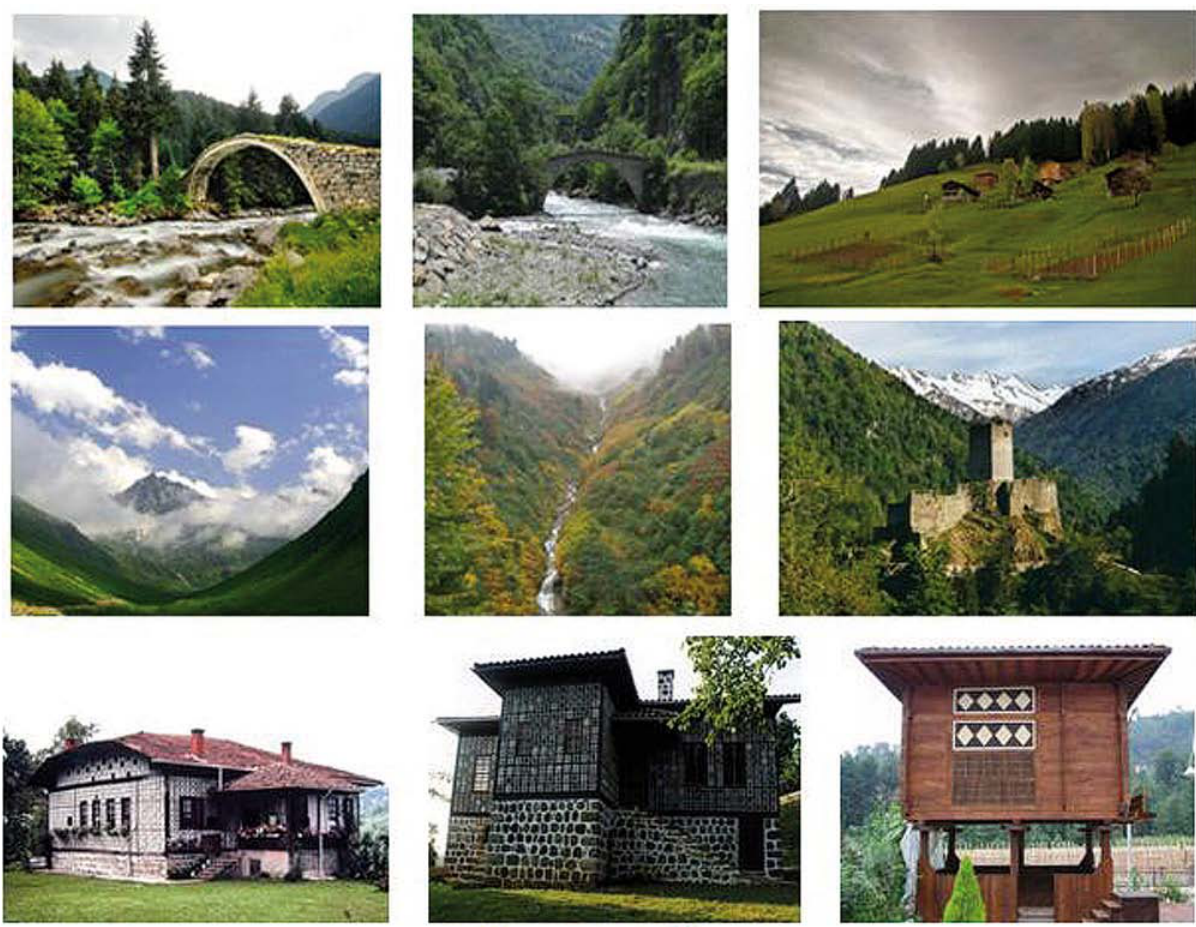
Fig. 1. Some views of Fırtına